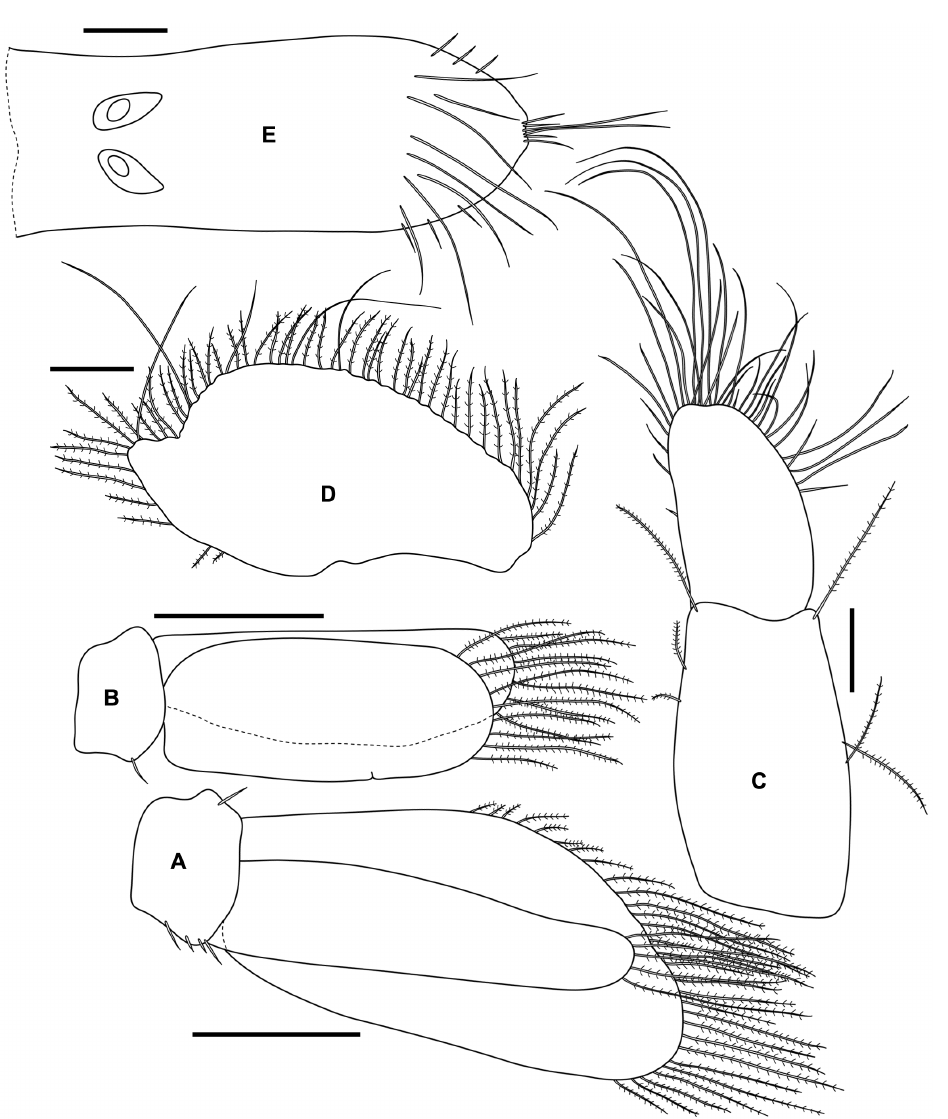
Figure 6. Tinggianthuraalba sp. n., holotype, female, (UKMMZ-1479). All scales represent 0.1 mm. (A) pleopod 1, (B) pleopod 2, (C) uropodal endopod, (D) uropodal exopod, (E)